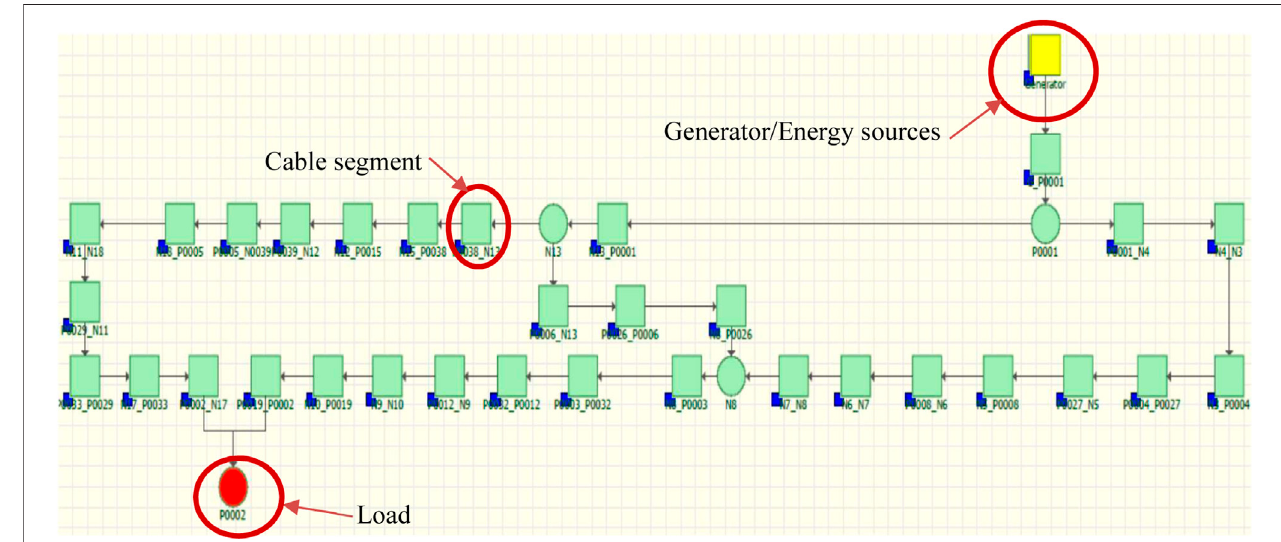
FIGURE 19 | Load node P0002 reliability block diagram.